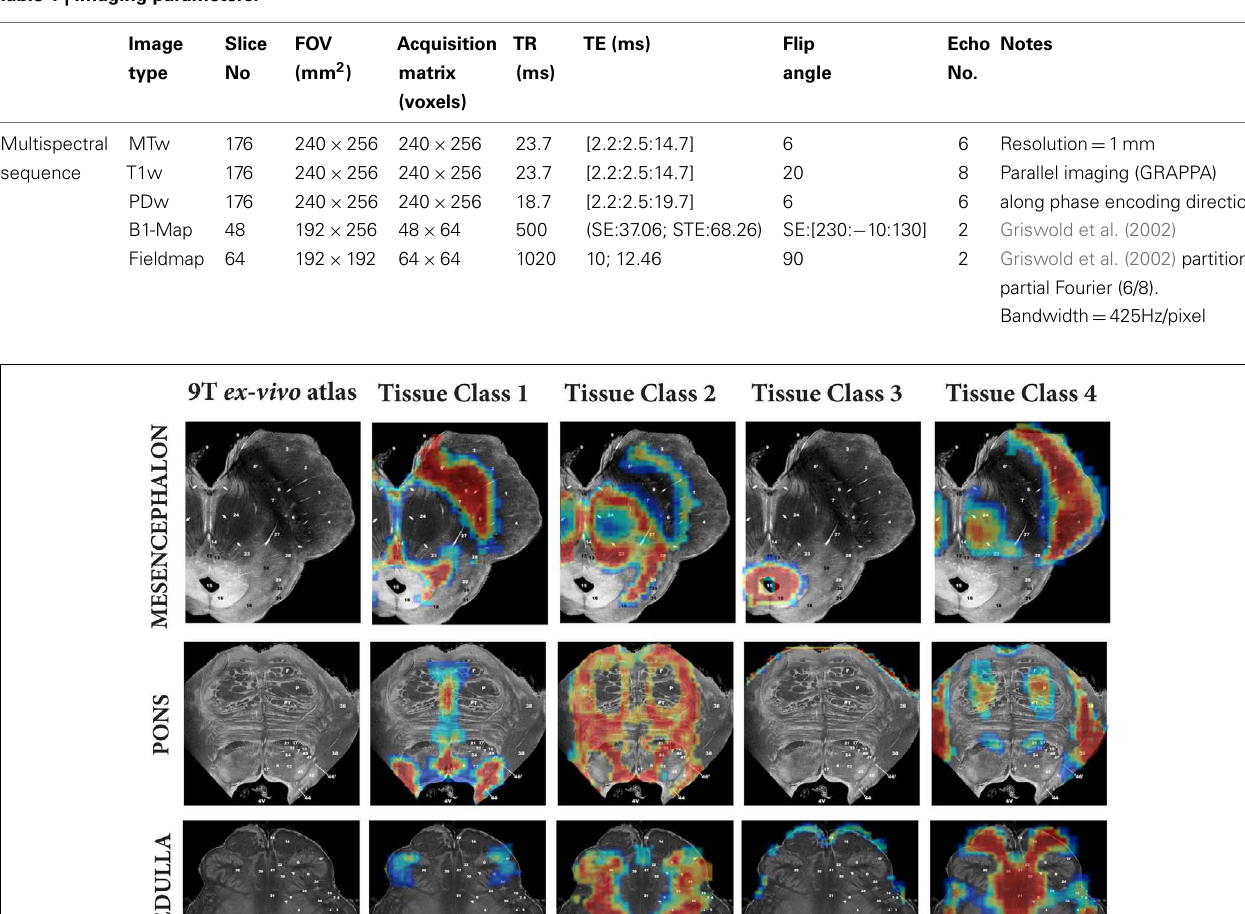
The actual brainstem segmentation step is summarized